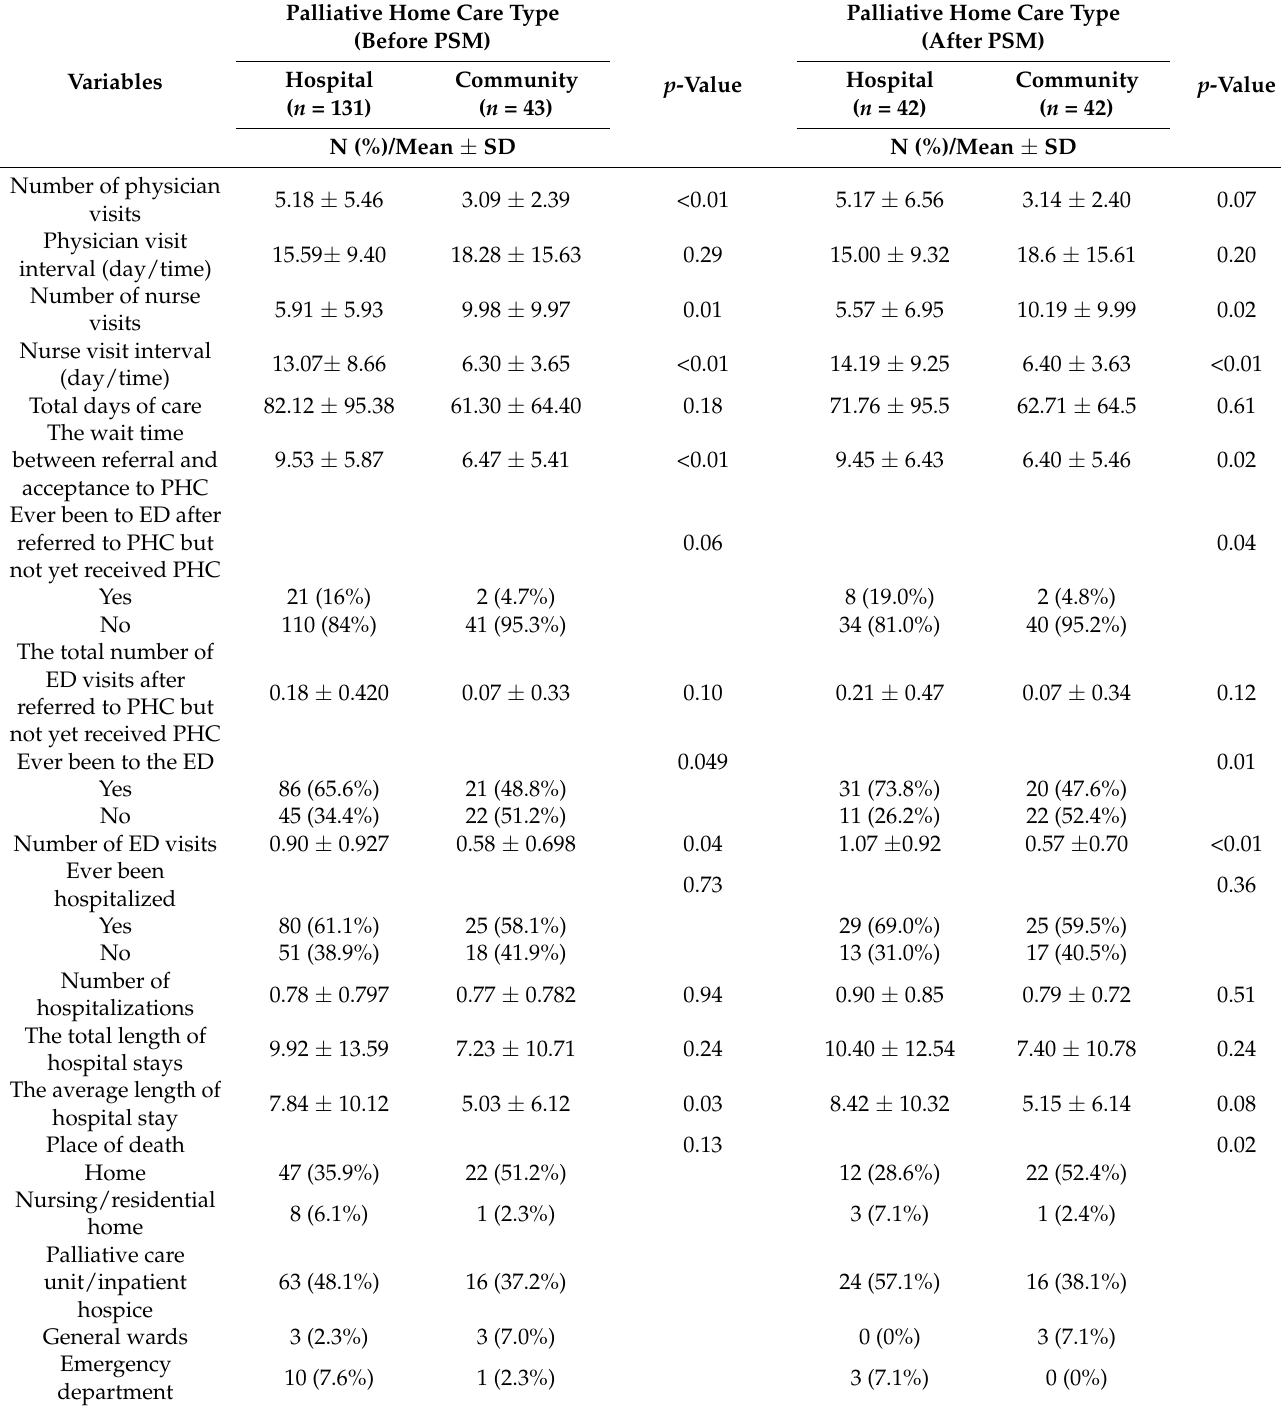
Table 2. Medical utilization condition of enrolled patients after receiving